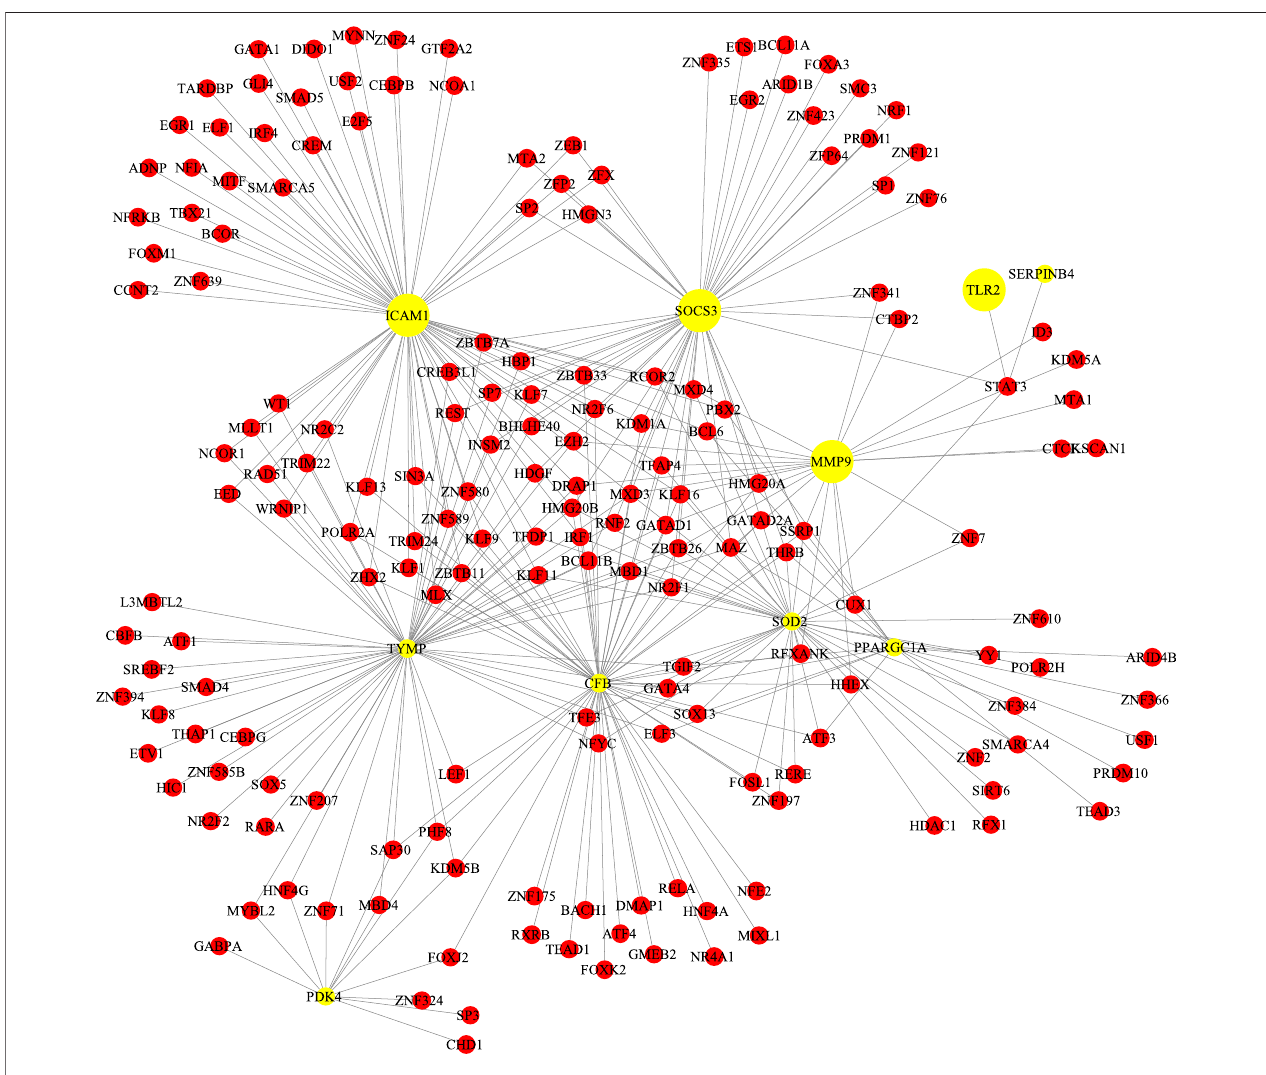
FIGURE 6 | Network for transcription factor gene interplay with shared